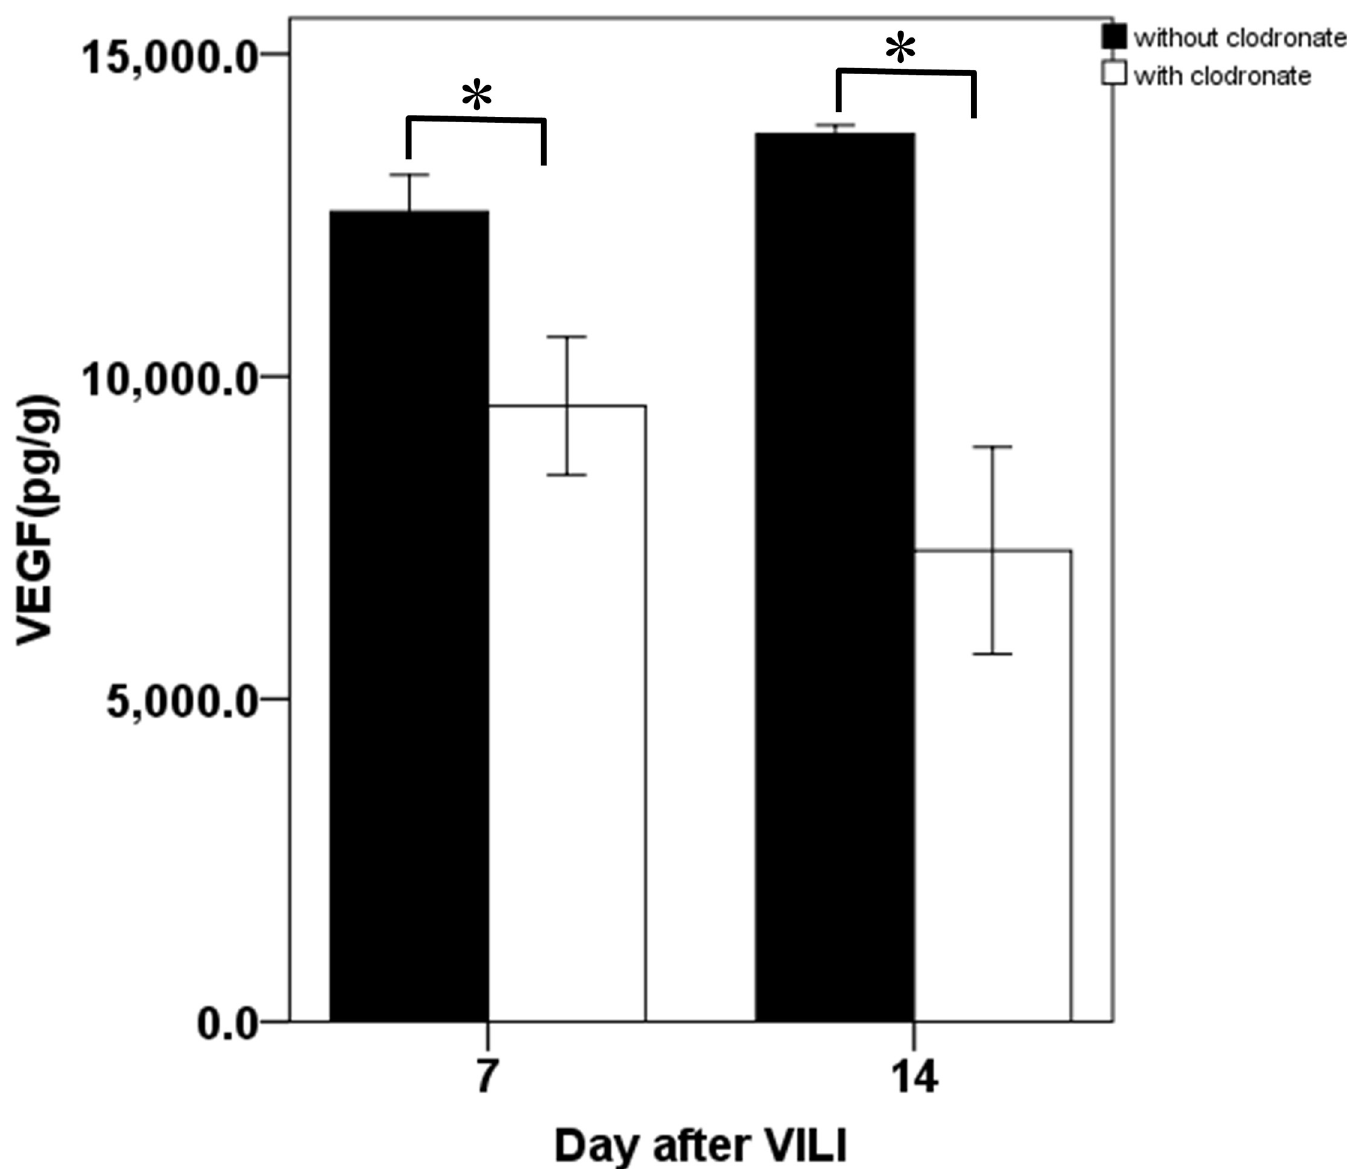
Fig 6. Pulmonary VEGF protein levels in mice without and with depletion of monocytes on days 7 and 14 after VILI. Mice treated with clodronate for depleting pulmonary monocytes underwent the same protocol as the two-hit VILI. The mice sacrificed on day 7 after VILI were injected with a single 200 uL dose of Clophosome- A intravenously on day 3 after VILI. The mice sacrificed on day 14 after VILI received the same treatment of Clophosome-A on day 3 and reinjection of 100 uL on days 7 and 11 after VILI. VEGF protein concentration in lung tissue was determined by ELISA. Data are expressed as mean ± SD; n = 6 per group, � p = 0.002, compared between without and with clodronate treatment groups using Mann-Whitney U